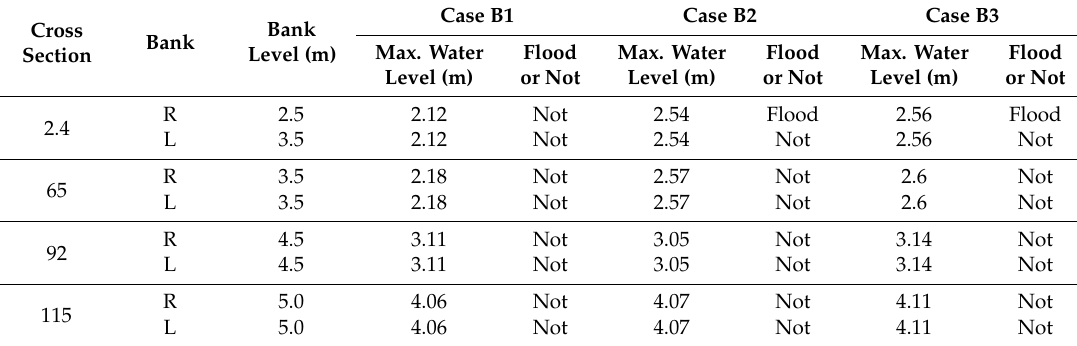
Figure 27. Maximum water level profiles of the 200 m 3 /s wave for all considered cases.